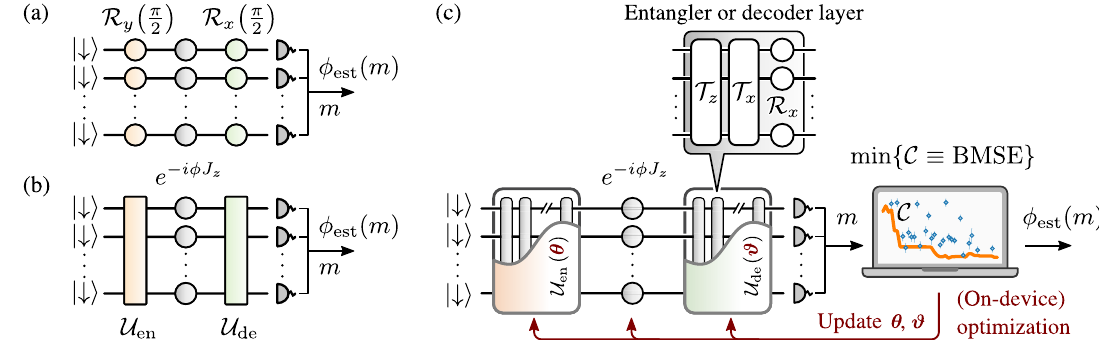
FIG. 1. (a) Quantum circuit representation of Ramsey interferometer with uncorrelated atoms. The phase ϕ is imprinted on the atomic π = 2 Þ . Consequent rotation, R π = 2 Þ , and measurement of spin superposition prepared by global π = 2 rotation around y axis, R y ð x ð m Þ . difference m of atoms in eigenstates j ↑ i and j ↓ i in z basis allows estimating the phase ϕ using an estimator function ϕ est ð (b) Quantum circuit of a generalized Ramsey interferometer with generic entangling and decoding operations U and U , respectively. en de Our variational approach (c) consists of an ansatz, where optimal U and U are approximated by low-depth circuits. These are built en de from “ layers ” of elementary operations, which are provided by the given platform. We specify the variationally optimized quantum θ Þ and U ϑ Þ [see Eqs. (6) and (7)], of depth n sensor by circuits U and n , respectively. Here θ ≡ f θ and ϑ ≡ f ϑ are vectors of i g i g en ð de ð en de variational parameters to be optimized for a given strategy represented by a cost function C defined here as Bayesian mean squared error (BMSE) [see Eqs. (2) and (10)]. We illustrate the approach with a variational circuit built from global spin rotations R and one-axis- x twisting gates T available in neutral atom and ion quantum simulation platforms, as discussed in Sec. II B. The circuit ’ s optimization, x;z shown as a feedback loop (in red), can be performed on a classical computer, or, if the complexity of underlying quantum many-body problem exceeds capabilities of classical computers, on the sensor itself, thus leading to a (relevant) quantum advantage; see Sec. II